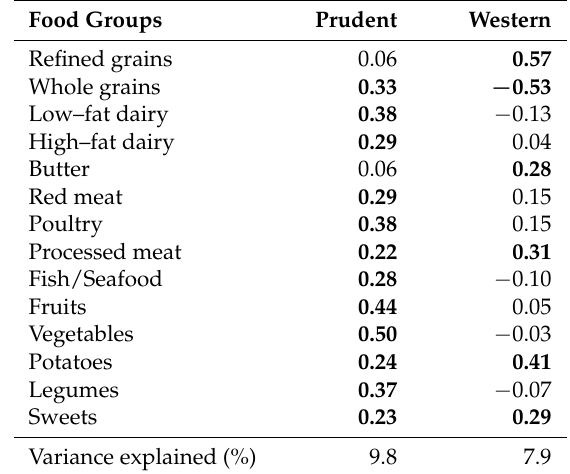
Table 1. Factor loadings of the food groups in dietary patterns (N = 1306)